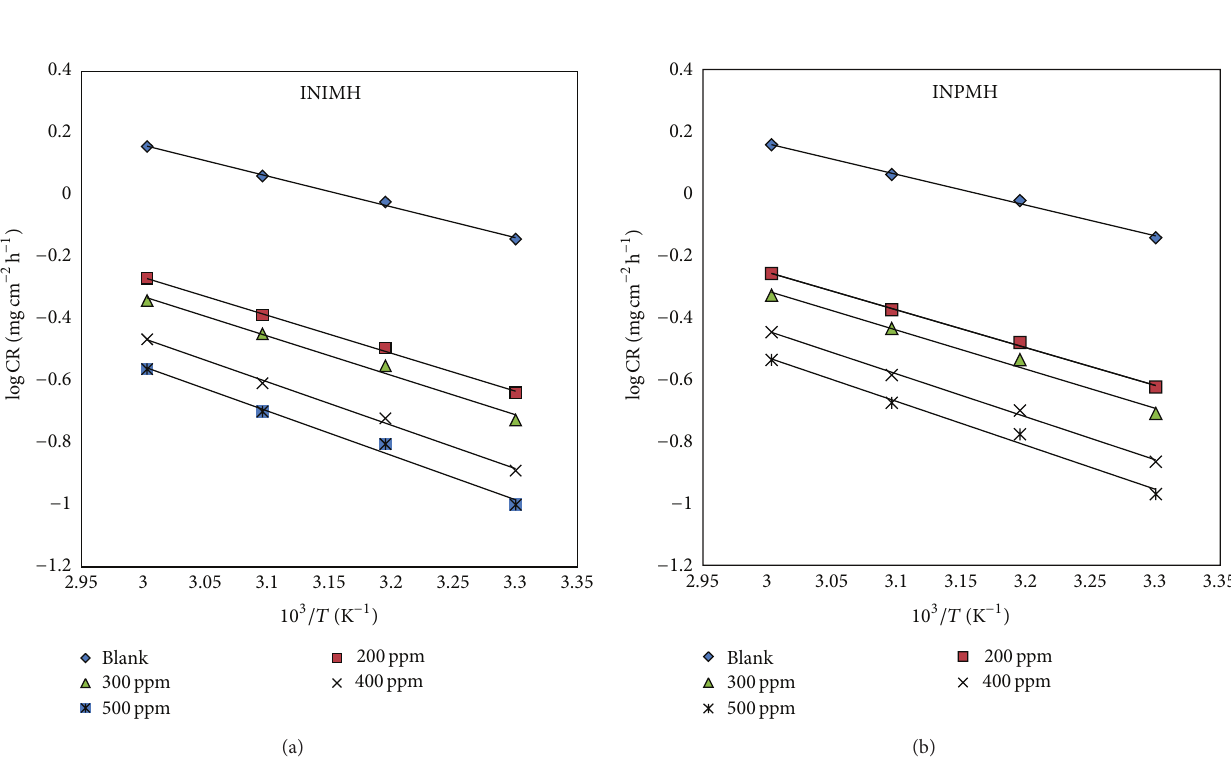
Figure 2: Plots of log CR versus 1/𝑇 for INIMH and